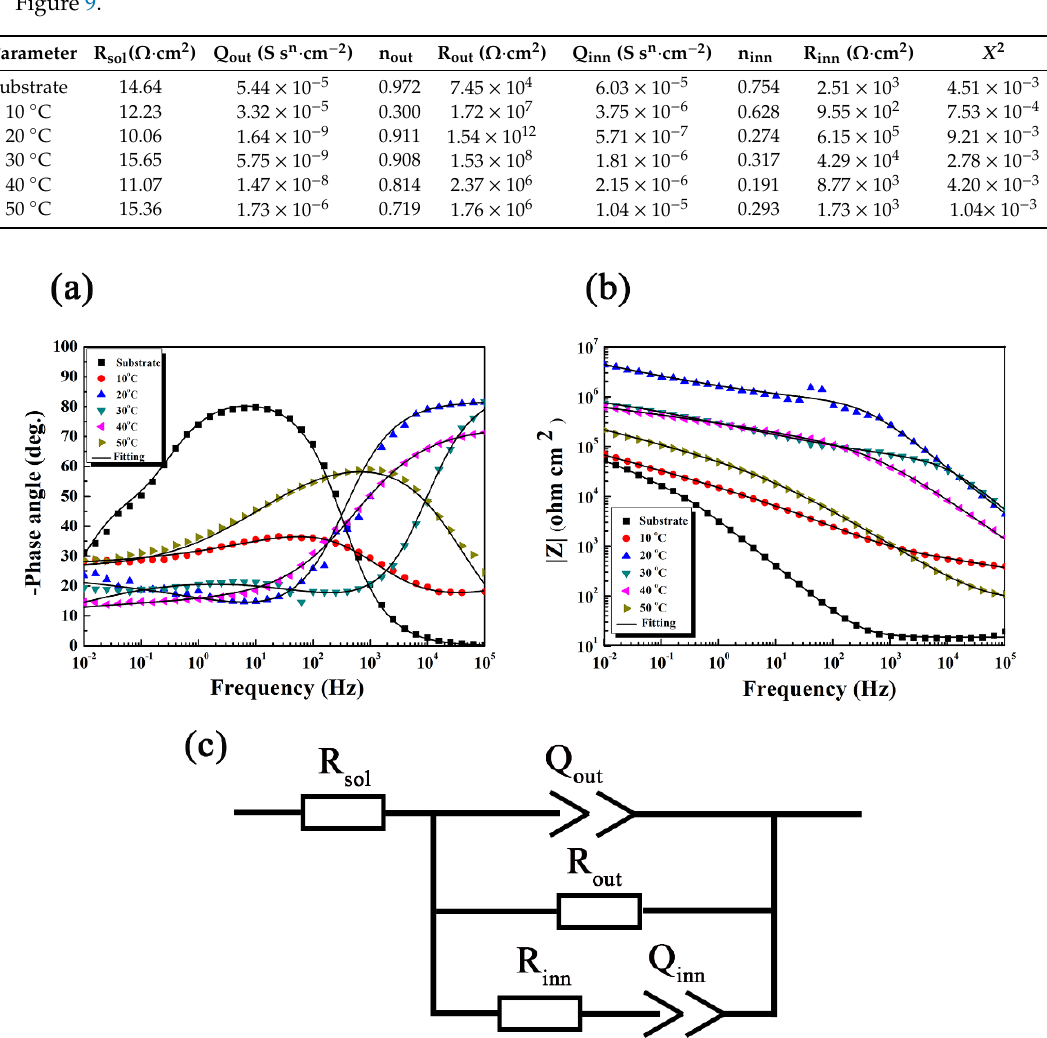
Figure 9. ( a , b ) are EIS plots of composite anodic films fabricated at different temperatures; ( c ) equivalent circuits used to fit EIS